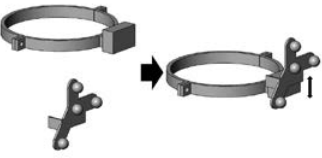
Fig. 1. Target ball positioning